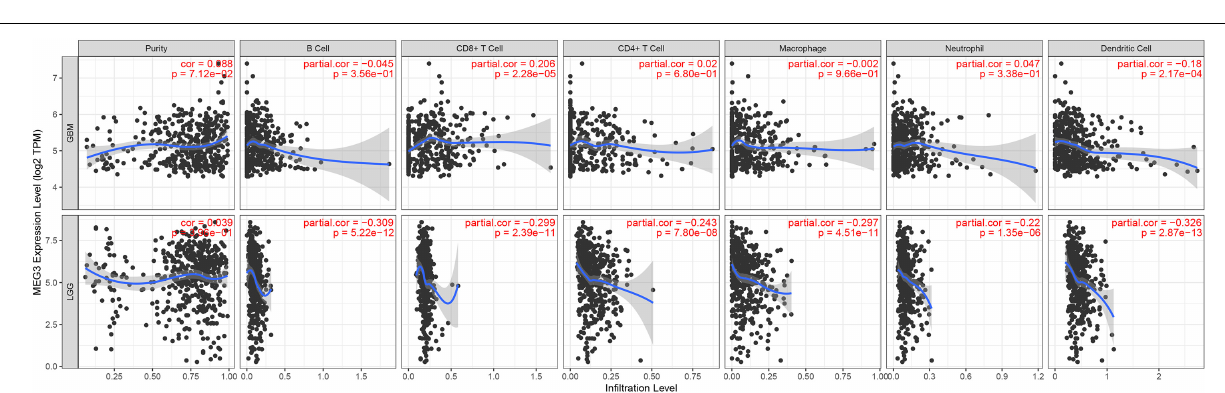
FIGURE 4 | Correlation of MEG3 expression with immune infiltration level in GBM and